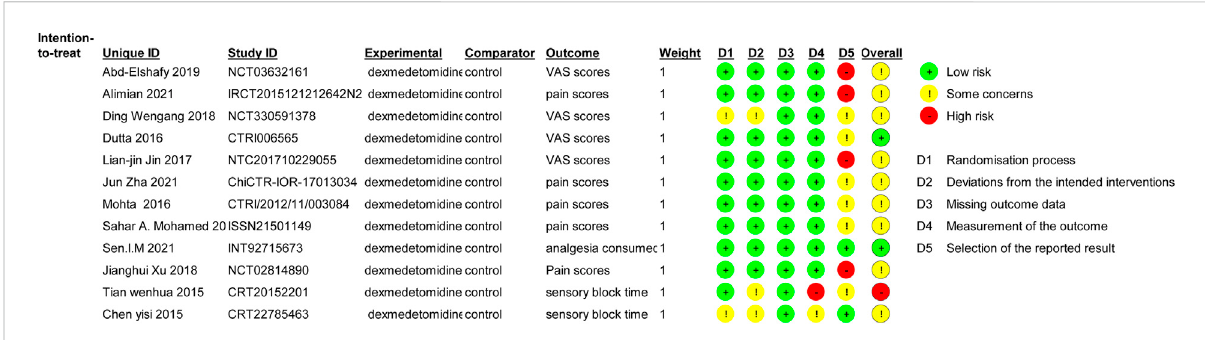
FIGURE 2 Risk of bias summary. Review authors ’ judgments about each risk of bias item for each included study. Green circle, low risk of bias; red circle, high risk of bias; yellow circle, unclear risk of